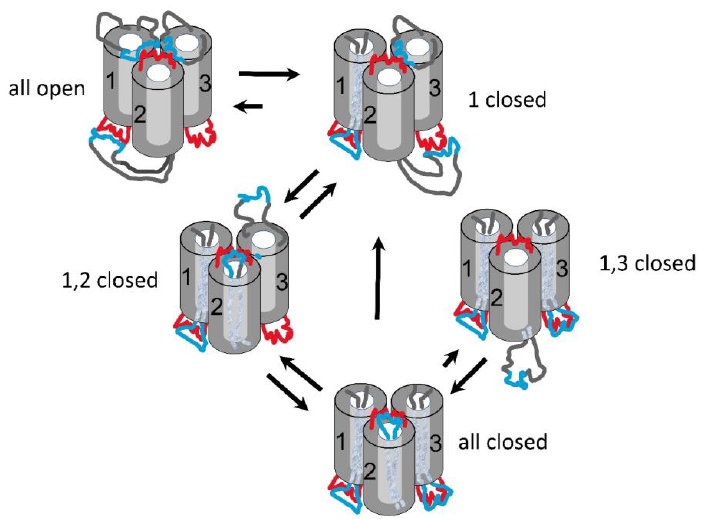
Figure 14. Revised model of the gating of Triplin based on the results presented. The top of the structure is the cis side of the membrane, the side from which Triplin inserted. The bottom of the structure is the trans side and that is the side maintained at virtual ground by the amplifier. All indicated voltages refer to the cis side. The numbers 1,2,3 refer to pores 1,2 and 3. Short arrows refer to reactions of lower probability. For simplicity, the closed state of the pore is illustrated as the result of blockage by a single loop of the beta barrel but, of course, multiple loops may be involved. The latter interaction is weak because of the repulsion of the two positive sensor do- mains from subunits 1 and 3. The application of a positive voltage on the cis side (top of the model) results in the closure of either subunit 1 or 3 and whichever closes is labeled as subunit 1. Closure is proposed to involve the entry of the loop region into the pore, thus, obstructing ion flow and resulting in a closed state. Such an intrusion of a loop region into a beta barrel is a feature of many porins [1]. Once the positively charged loop is in the pore, it interacts with the proposed negative region and is, thus, stabilized. The closure of subunit 1 results in a tighter interaction between the sensor of subunit 3 and the negative region of subunit 2. Therefore, the sensor of subunit 3 becomes una- vailable for reaction with anhydride or cleavage by trypsin. The closure of subunit 2 re- moves this interaction, allowing the sensor of subunit 3 to be available for reaction and gating.